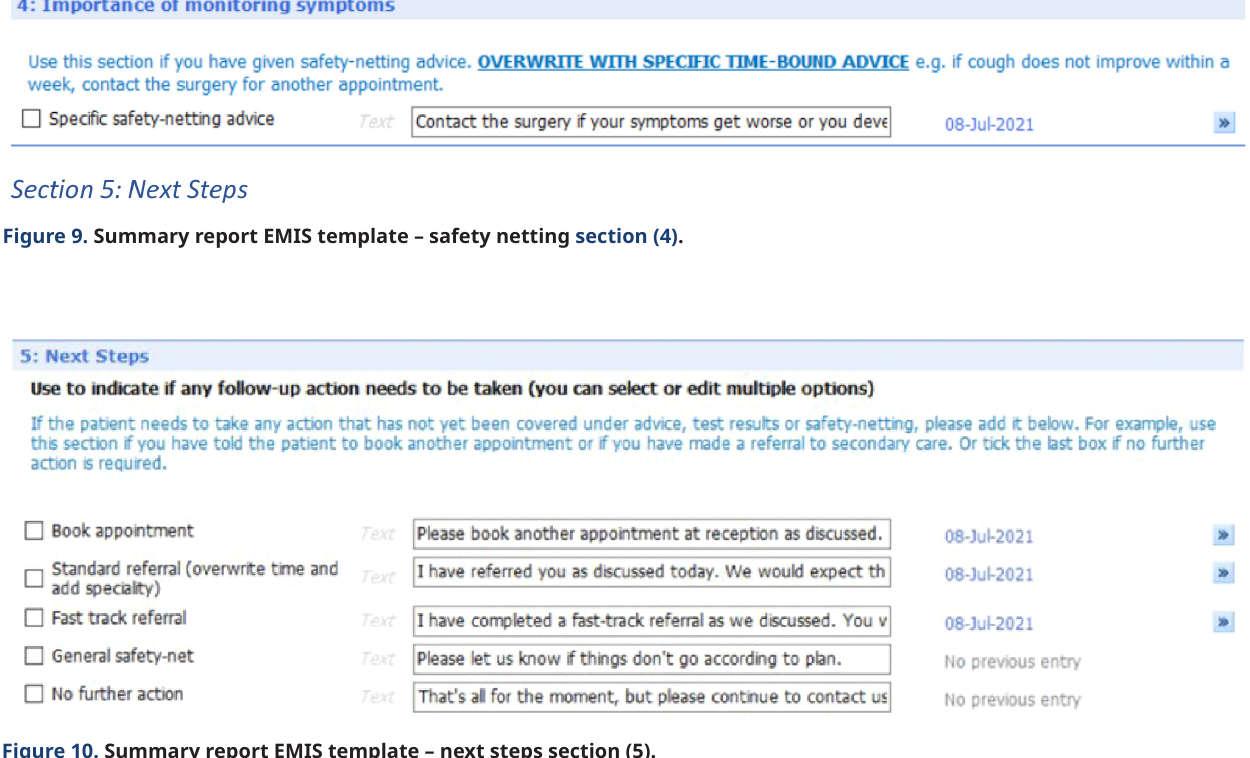
Figure 10. Summary report EMIS template – next steps section (5).